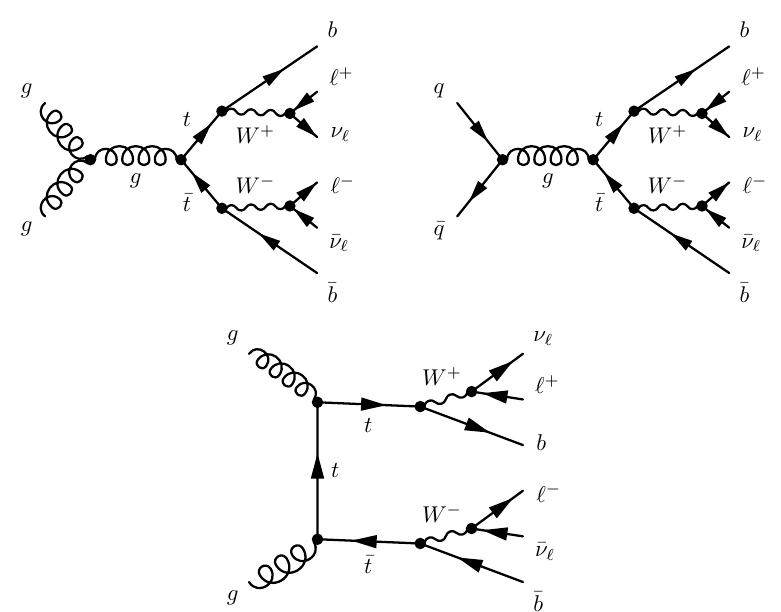
Figure 5. t ¯ t background topologies with fully leptonic final states. All particles shown here are purely SM ones. The final leptonic channels in both the signal events and the t ¯ t background processes shown here are chosen to be identical.